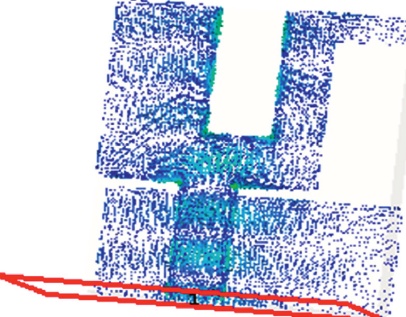
Figure 4: VSWR of the antenna at 60GHz.